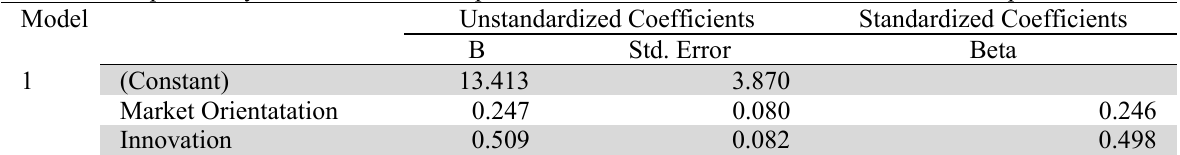
The results of path analysis for the relationship of market orientation and innovation on business performance Model